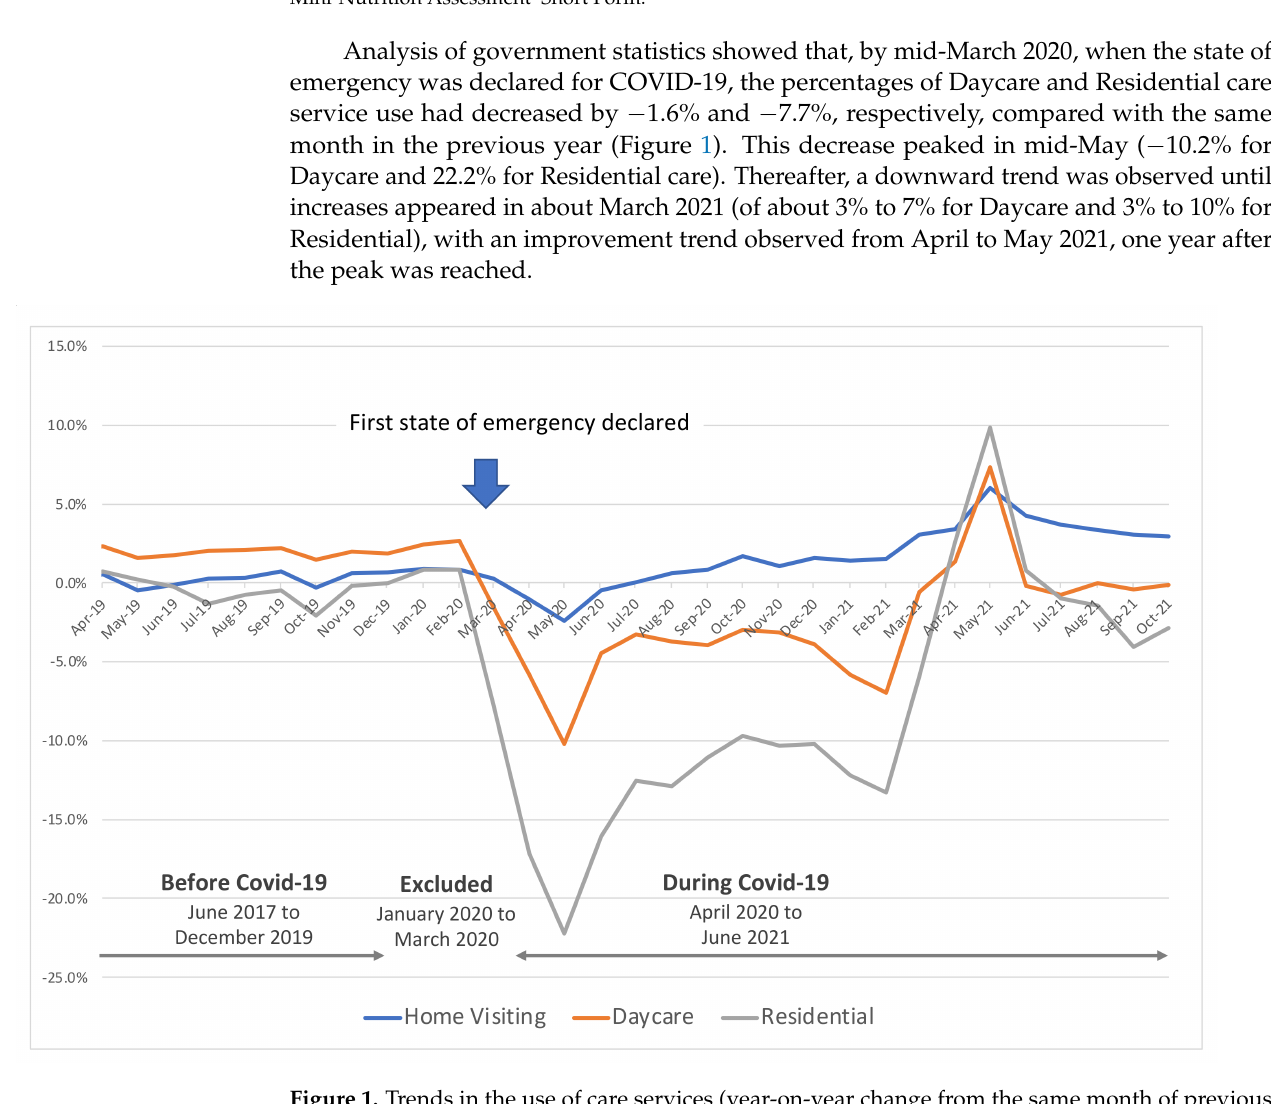
Figure 1. Trends in the use of care services (year-on-year change from the same month of previous year): analysis of government statistics (https://www.kokuho.or.jp/statistics/kaigo/, accessed on 24 February